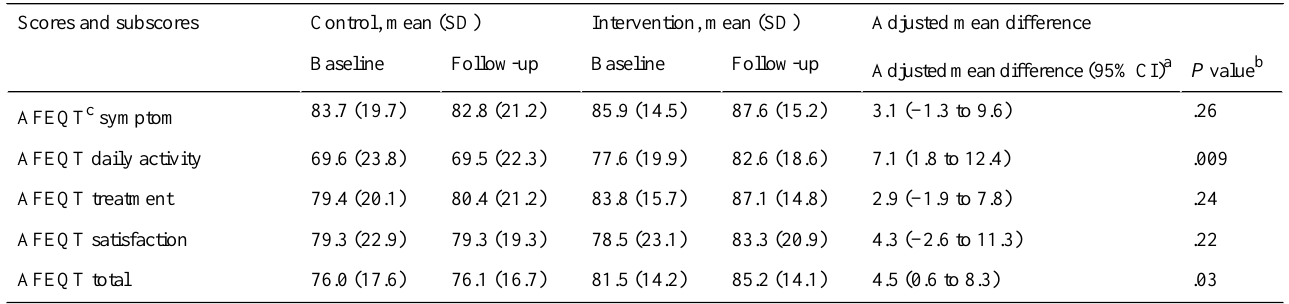
Adjusted mean differenceIntervention, mean (SD)Control, mean (SD)Scores and subscores